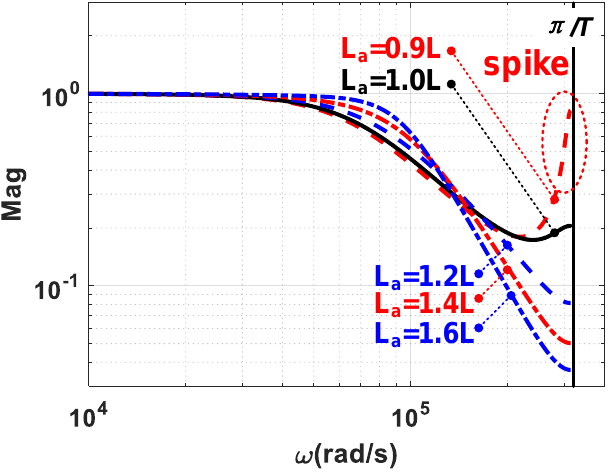
Figure 17. Closed-loop frequency analyses under DPVP control for the v REF - > v out, s transient under deviated inductance.